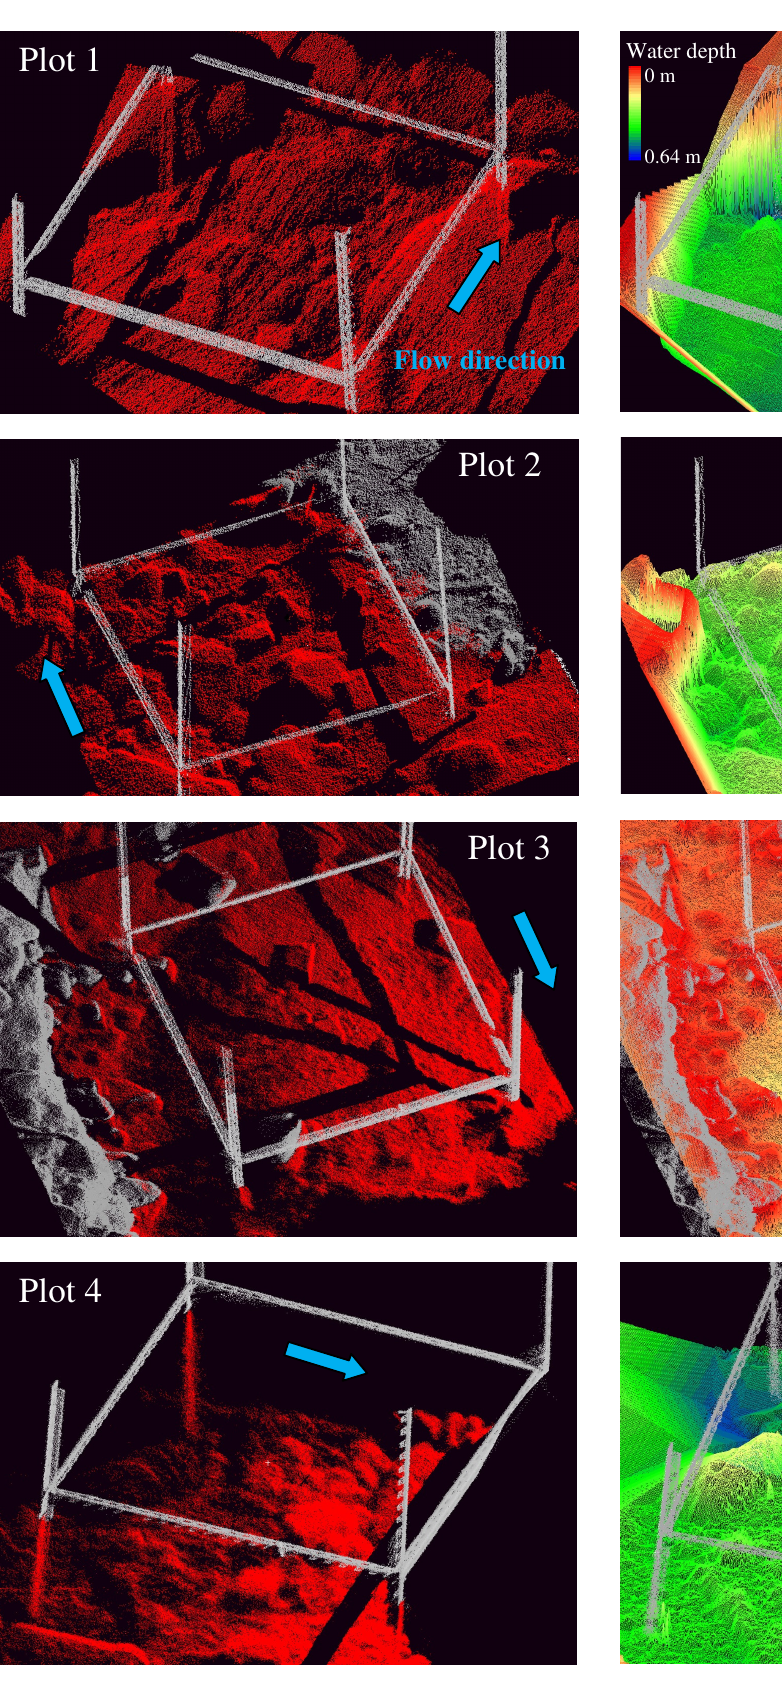
Figure 5. Water refraction corrected point cloud (left) and DTM (right) for the 4